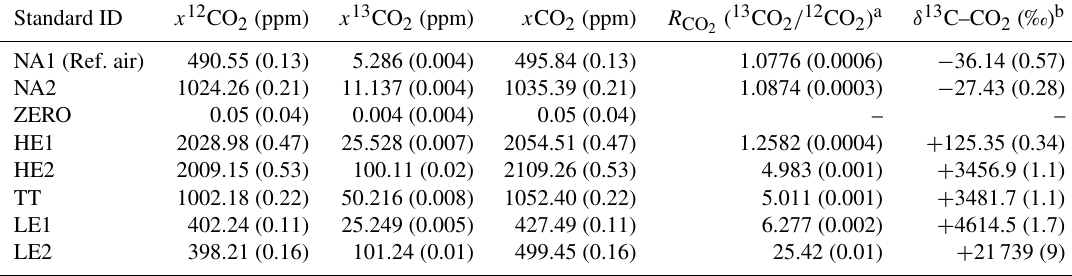
Table 1. Bottle measurement data of the standard air used as baseline for syringe sample measurements (NA1) and the gas standards used in method calibration (NA2 to LE2). Values are the averages (SDs in parentheses) of 10min measurements taken for each standard directly inlet to the CRDS analyser (see Sect. 2.3). Data have been post-corrected as per the calibration of Dickinson et al. (2017). Standard ID x 12 CO 2 (ppm) x 13 CO 2 (ppm) x CO 2 (ppm) NA1 (Ref. air) 490.55 (0.13) NA2 HE1 TT 1002.18 (0.22)